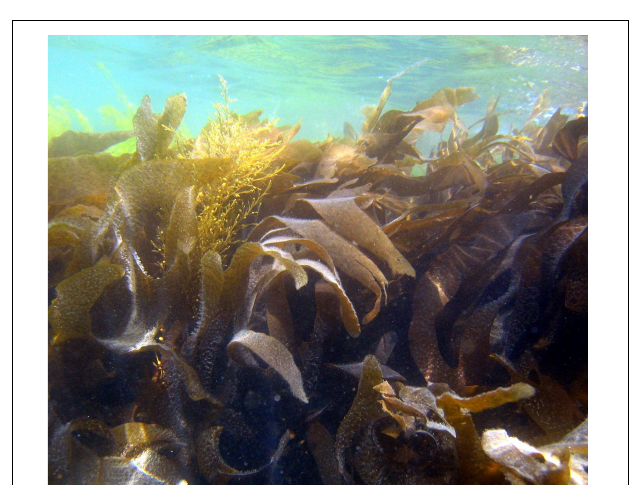
hatchery produced juveniles were released in eastern